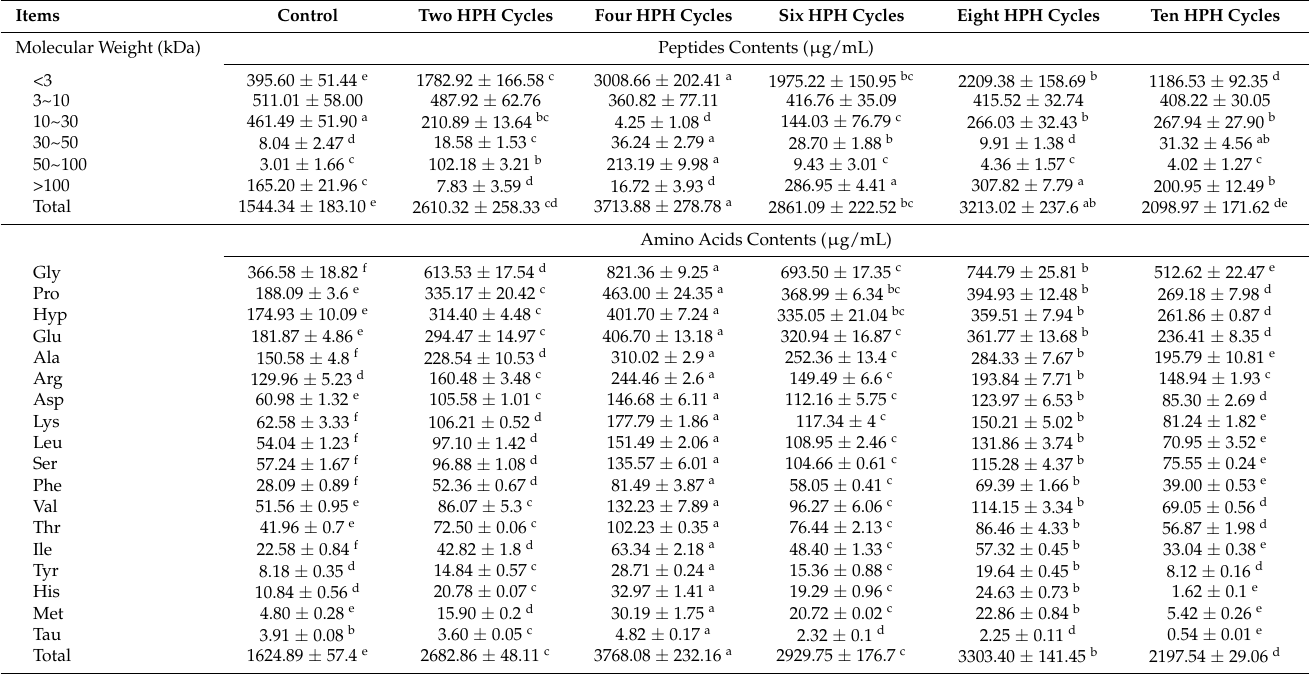
Table 3. Peptide contents with different molecular weights and amino acid compositions in the supernatants of